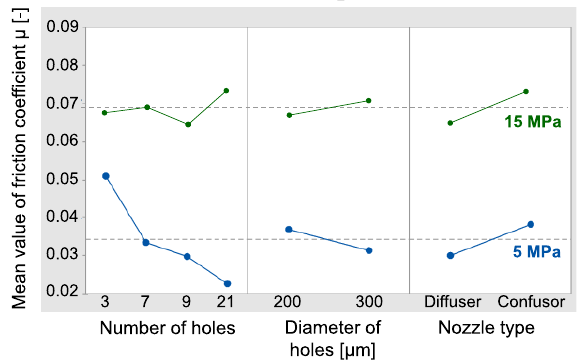
Fig. 14. Main effects on coef fi cient of friction m determined with strip drawing investigations at 5 MPa (lower, blue values) and 15 MPa (higher, green values) surface pressure, drawing speed 100 mm/s, lubrication medium CO 2 . All values represent averaged values for the respective con fi guration